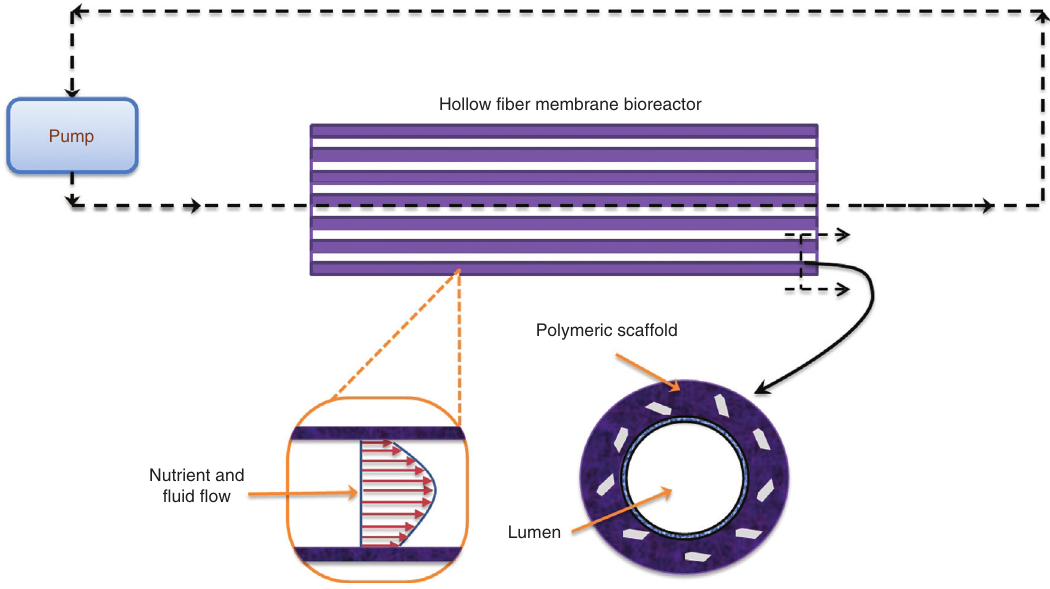
Figure 1 Schematic representation of a HFMB.